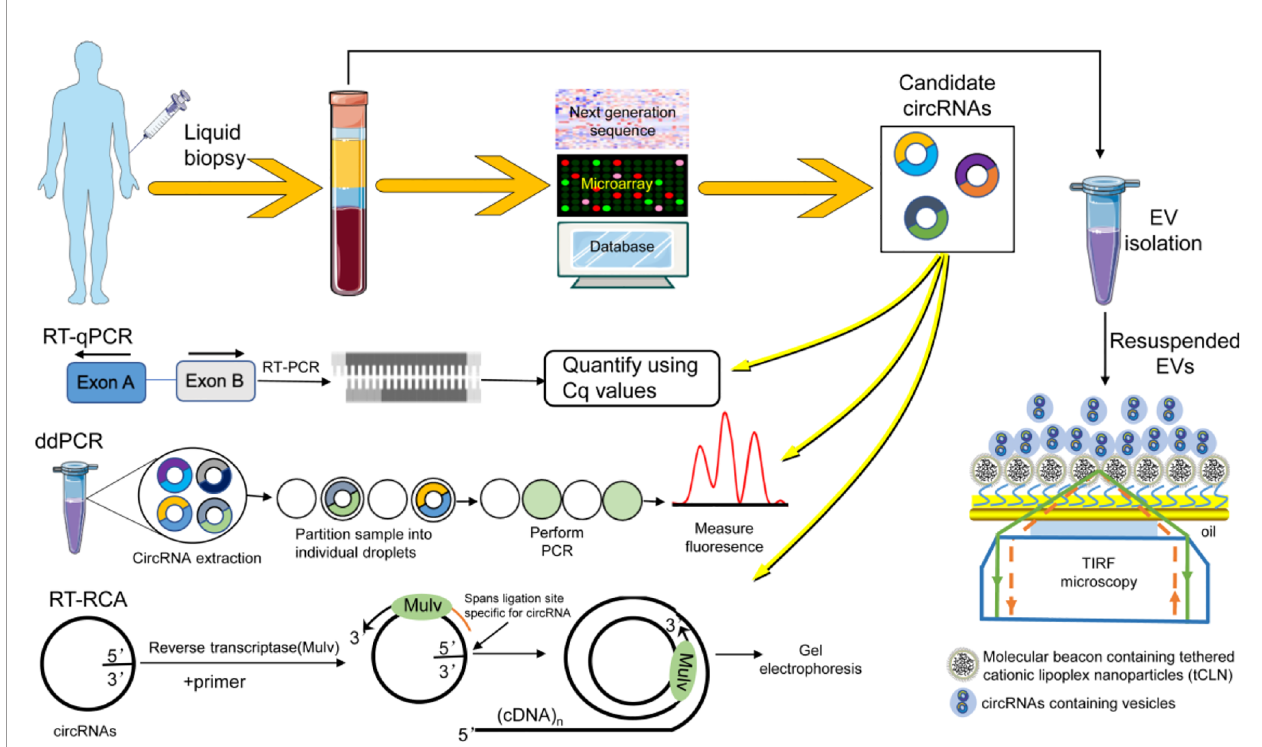
FIGURE 2 | The detection method of circRNA in liquid biopsy. RNA-seq was used to identify and analyze candidate circRNAs with differential expression. Techniques such as RT-qPCR, ddPCR, RT-PCA, and tCLN were used to detect the level of circRNA in biological fl